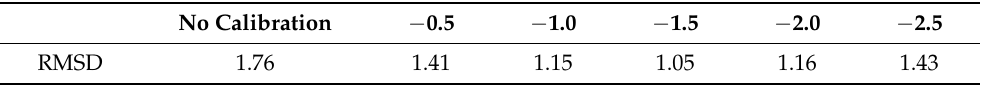
Table 1. The effect of root-mean-square deviation (RMSD) while comparing observed and estimated dew-point temperatures without adjustment and with five levels of adjustments. No Calibration − 0.5